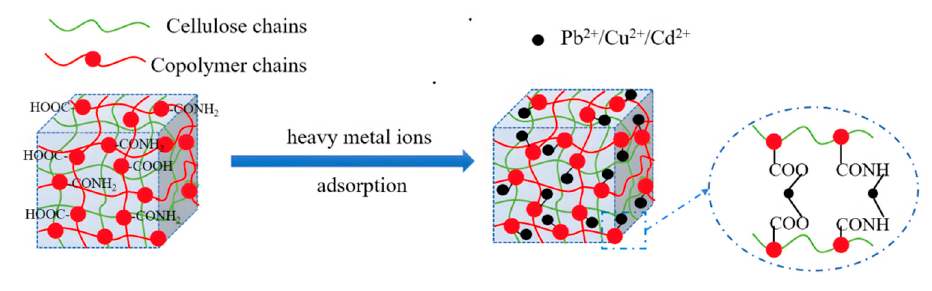
Figure 12. Ion exchange and electrostatic interactions mechanism.